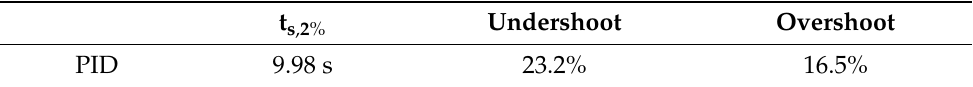
Table 11. Comparison among all the tested controllers: recovering from a disturbed attitude.